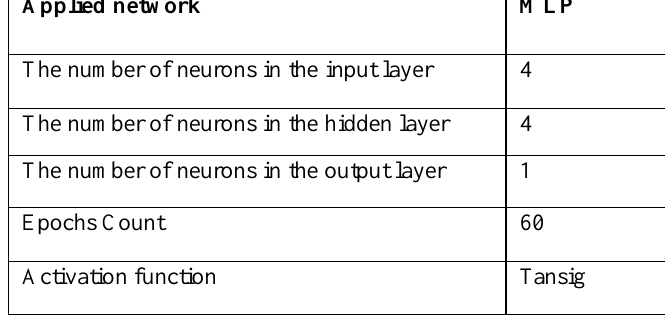
Artificial grid specifications designed to detect human behavior patterns.